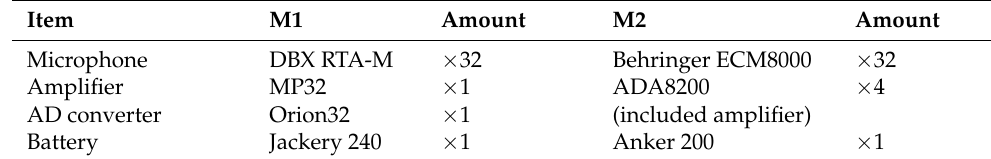
Table 3. System components and quantities for the respective microphone arrays: M1 and M2.